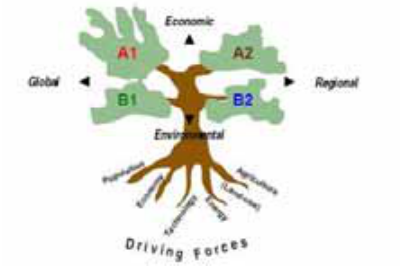
Figure 1. The four IPCC SRES scenario storylines (source: Nakicenovic et al. , 2000) In simple terms, the four storylines combine two sets of divergent tendencies: one set varying between strong economic values and strong environmental values, the other set between increasing globalization and increasing regionalization (Figure 1). Here we have chosen two regional storyline (one with strong economic development and the other with strong environmental development) to understand the impact under these two extreme situation. For this investigation the cropping system model CropSyst (Stockle, et al., 1994) which has been modified for simulating the crop growth under varying levels of CO 2 was